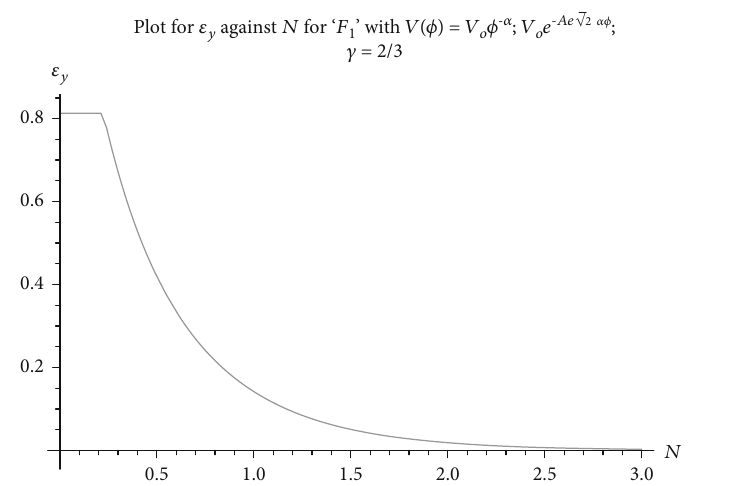
Figure 18: Shows the variation of perturbations along the y -axis ( ϵ power law forms.